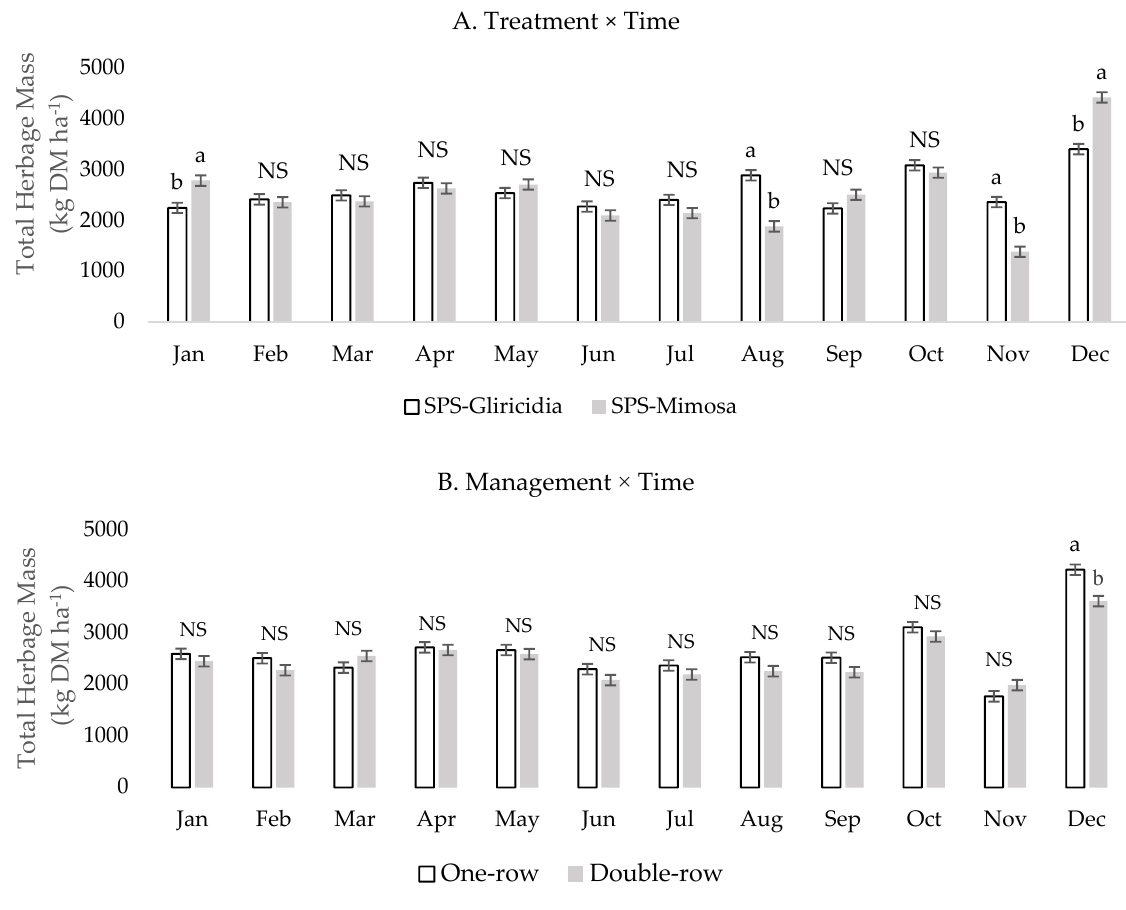
Figure 2. Total herbage mass of legume trees under different tree canopy management during the experimental period. Subfigure ( A ) denotes Treatment × Time interaction and subfigure ( B ) denotes Management × Time interaction. Different letters between treatments within each month indicate significant difference using the PDIFF procedure adjusted to Tukey ( p < 0.05). NS = non-significant. Data averaged across two experimental years and three blocks. SPS = silvopasture system. Table 1. Total green herbage mass (kg DM ha − 1 ) for both systems during the experimental